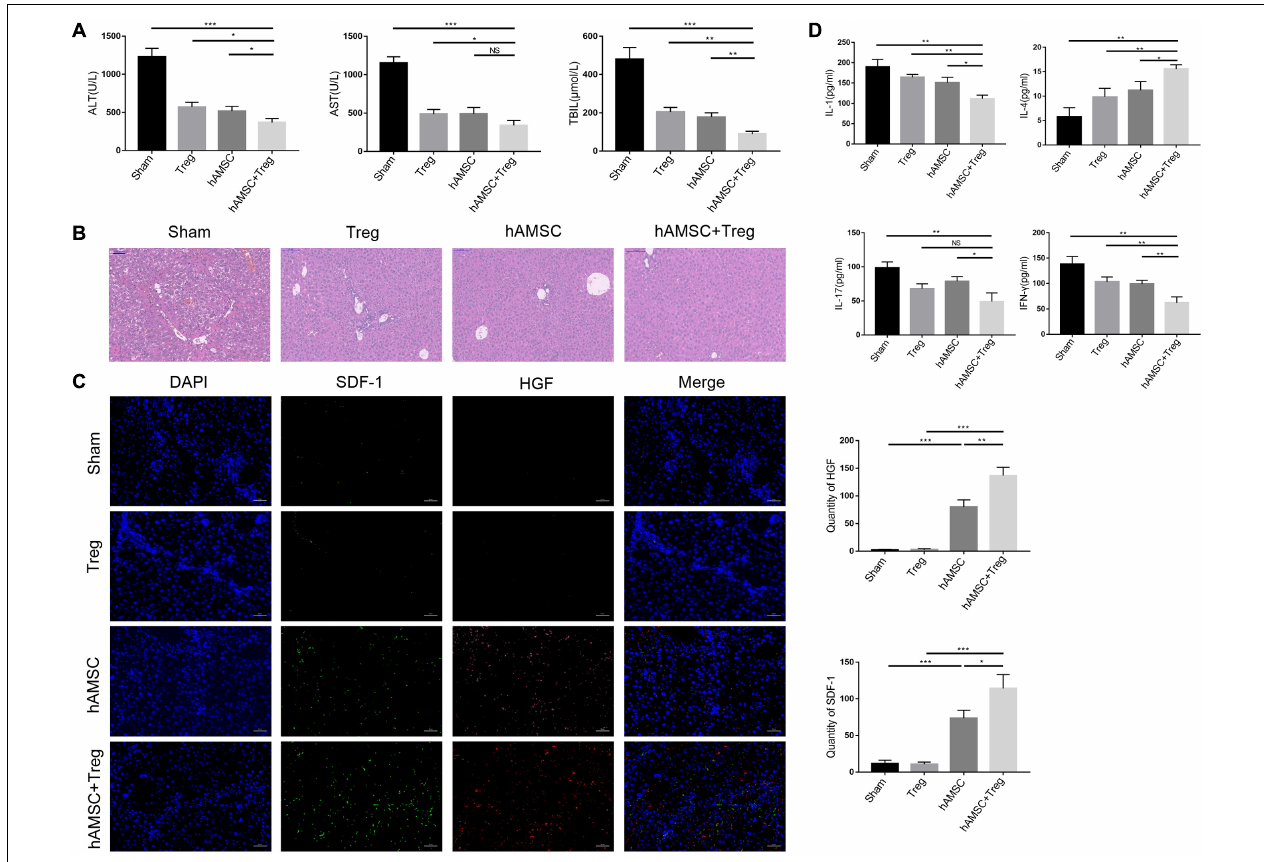
FIGURE 1 | PBS, Treg, hAMSC, and hAMSC + Treg were injected into mice through the tail vein, respectively. (A) Level of ALT, AST, and TBIL of four groups. (B) Representative images of liver tissue [hematoxylin and eosin (HE) staining] by light microscopy in four groups. (C) Representative fluorescent images for SDF-1 and HGF in four groups were visualized by fluorescence microscopy, and DAPI was used to mark nuclei. (D) Level of IL-1, IL-4, IL-17, and IFN- γ in sham group, Treg group, hAMSC group, and cotransfer group. The result is representative of three independent experiments. Data were mean ± SD of three independent experiments. * p < 0.05, ** p < 0.01, *** p <